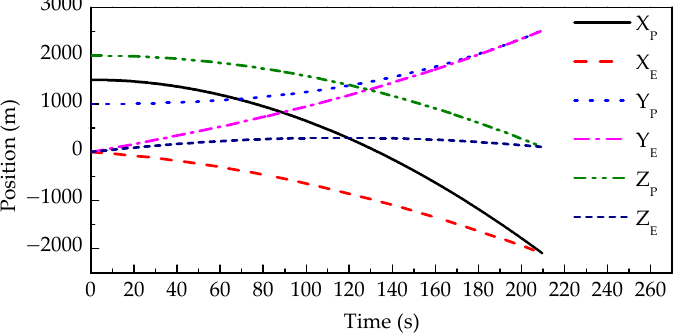
Figure 4. The position of each player changing with time.